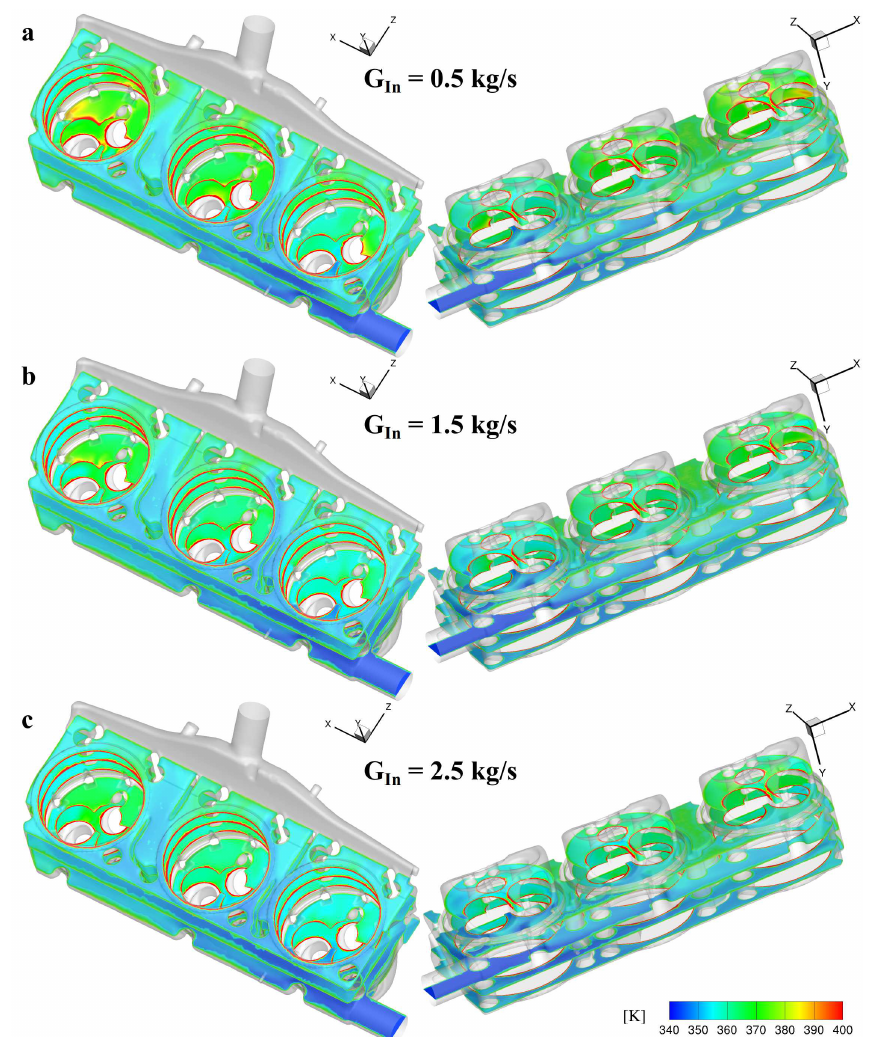
Figure 6. Temperature patterns for T Cyls = 440 K for the single-inlet geometry. Temperature contour plots for T Cyls = 440 K and G In = 0.5 ( a ), 1.5 ( b ), and 2.5 ( c )